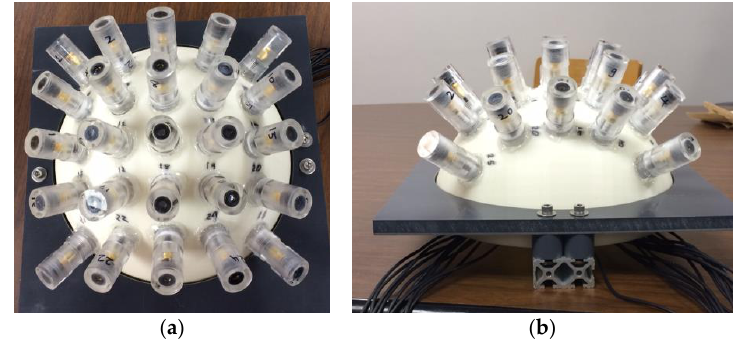
Figure 3. The optical detector array system prototype: ( a ) top view; and ( b ) side view.